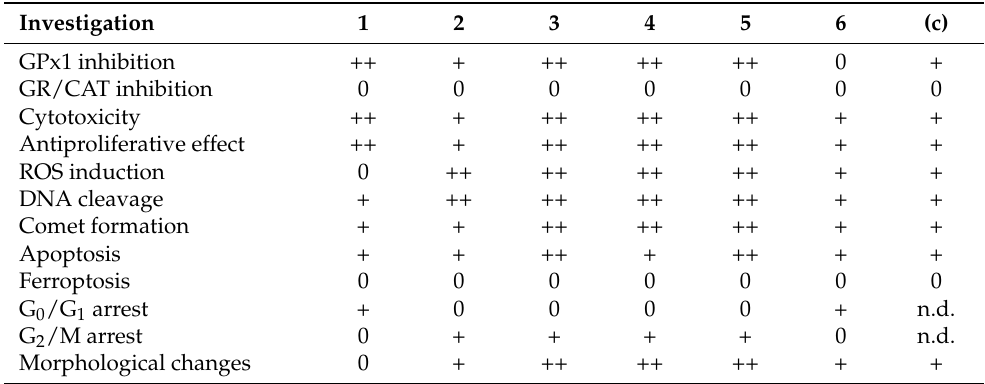
Table 2. Summary of the biological effects of pentathiepins 1 – 6 from the present study and ( c ) from the first generation of compounds [12] 1